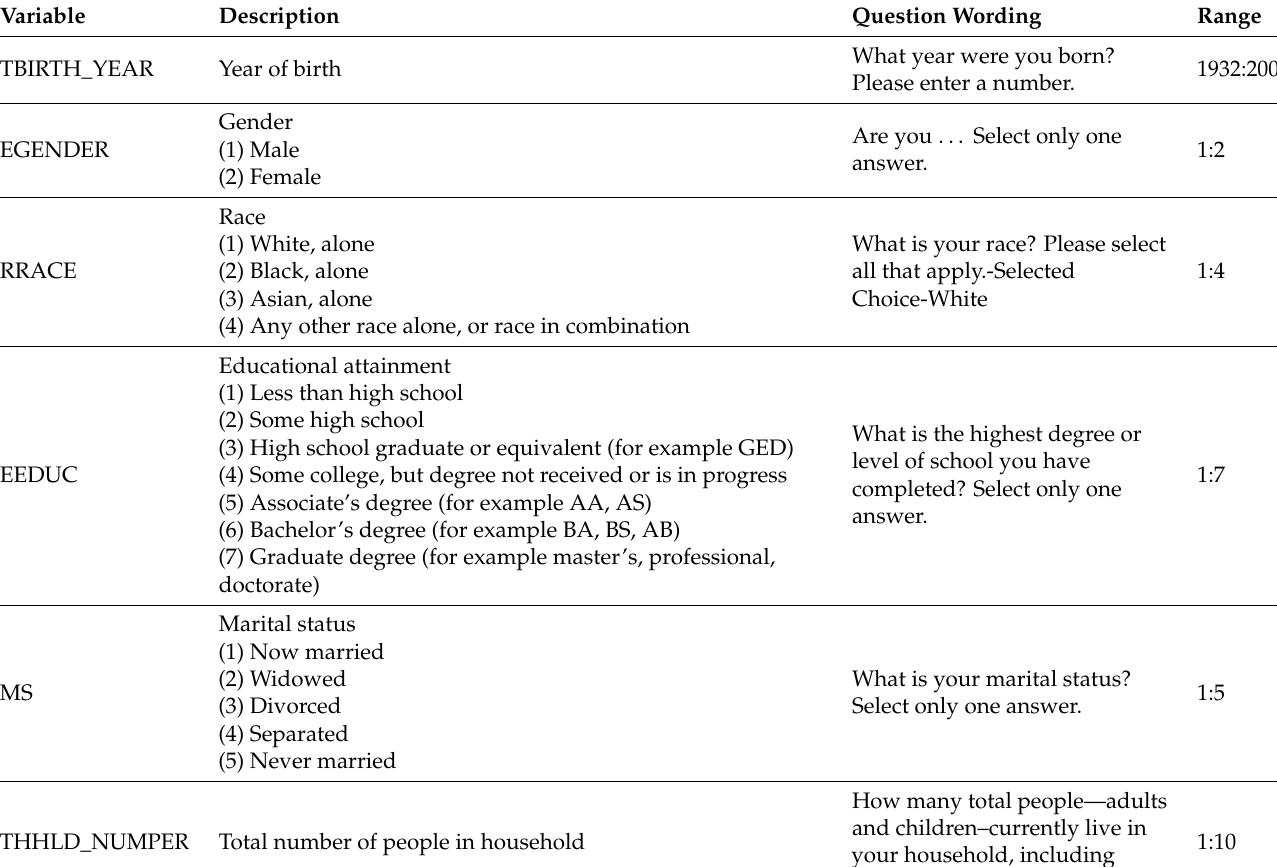
Table 1. Description of Household Pulse Survey